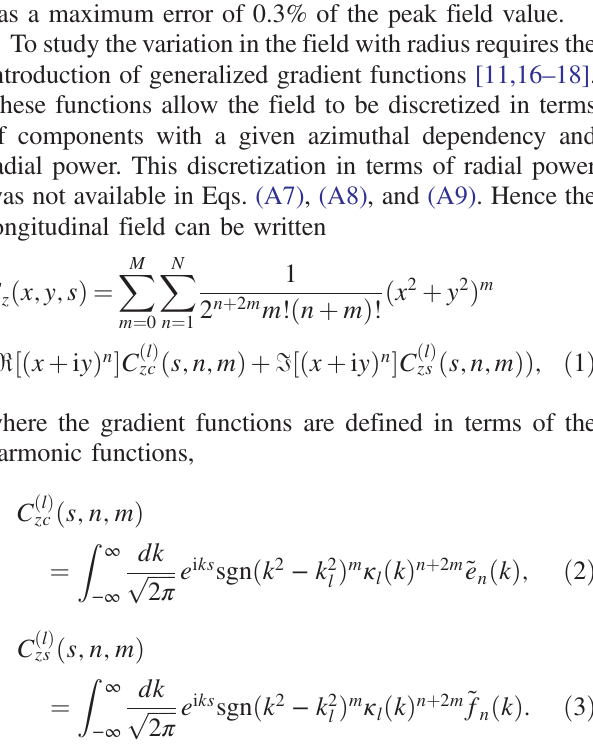
FIG. 4. E fitting error with varying x . Difference between interpolated and Taylor fitted fields; (a) E x and (b) E z . The error is normalized to the peak field value at the given x value along the whole length of the cavity. The error in E z has a maximum error of 0.3% of the peak field value.